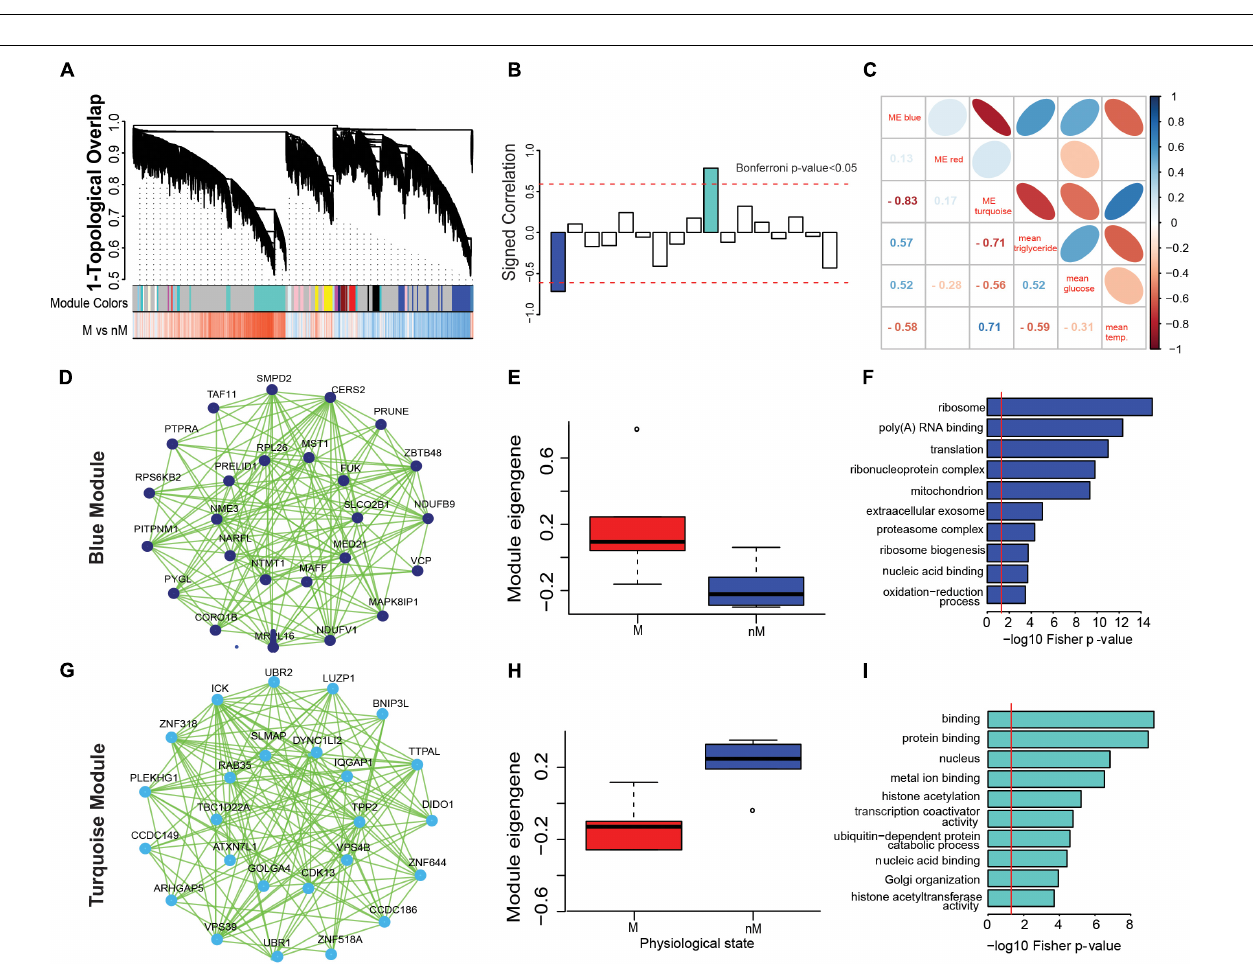
FIGURE 2 | Transcriptome-wide differential gene expression analyses. Top panel ( 2A1–A5 ): The flow-chart outlines steps of RNA sequencing, differential gene expression (DGE) analysis, and coexpression network analysis (A1) ; the distribution of nominal p-values from linear regression model employed to detect differential expression between photostimulated migratory (M) and photorefractory non-migratory (nM) states (A2) ; Venn diagram showing number of cyclic genes in M and nM states, as well as common to both states oscillating with an approximately 24-h period (A3) ; heatmap of 569 differentially expressed genes in two states (FDR < 0.1), in which scaled expression values are color coded; green- upregulated; red – downregulated (A4) , and volcano plot showing the log 2 fold change and negative log 10 nominal p-value for all the expressed genes, in which green and red circles represent downregulated and upregulated genes in the M state, as compared with the nM state (A5) . Bottom panels (B) : boxplots of significantly upregulated (left half; B1–B5 ) and downregulated (right half; B6–B10 ) genes included in a specific pathway, in the M state as compared with the nM state. Each boxplot is log 2 FPKM expression value in 5–95% intervals (outliers are shown dots). Wilcox Rank sum test was used to determine the significant change. For significance, alpha was set at 0.05.